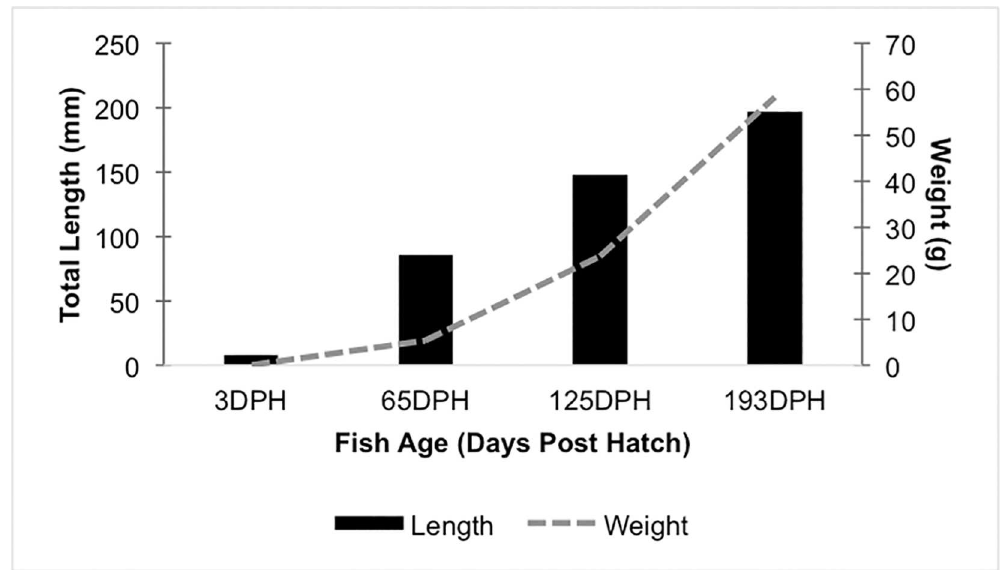
Fig 1. Weights and lengths of channel catfish sampled at 3, 65, 125, and 193 days post hatch (DPH). Mean fish weights(grams) plotted as a solid line and mean total length (mm) displayedas bars. Ten fish were measured at each time